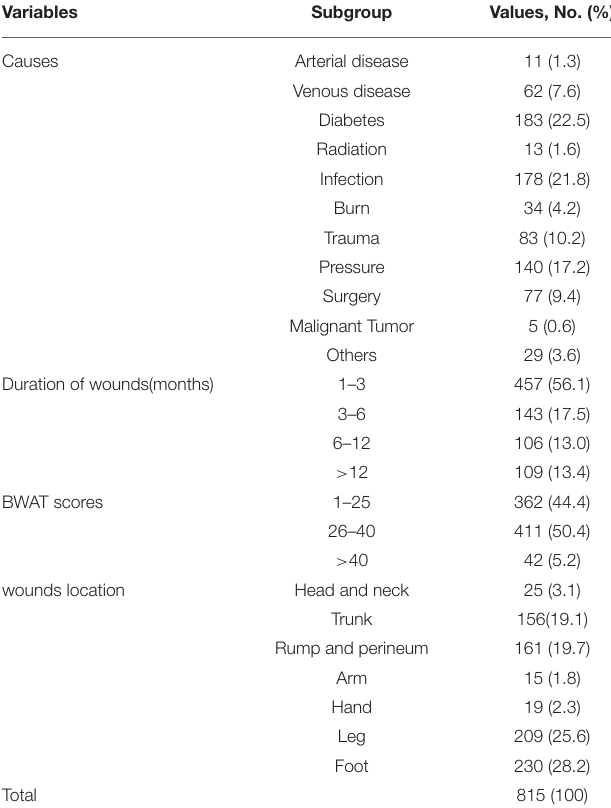
TABLE 2 | Features of patients’ chronic cutaneous